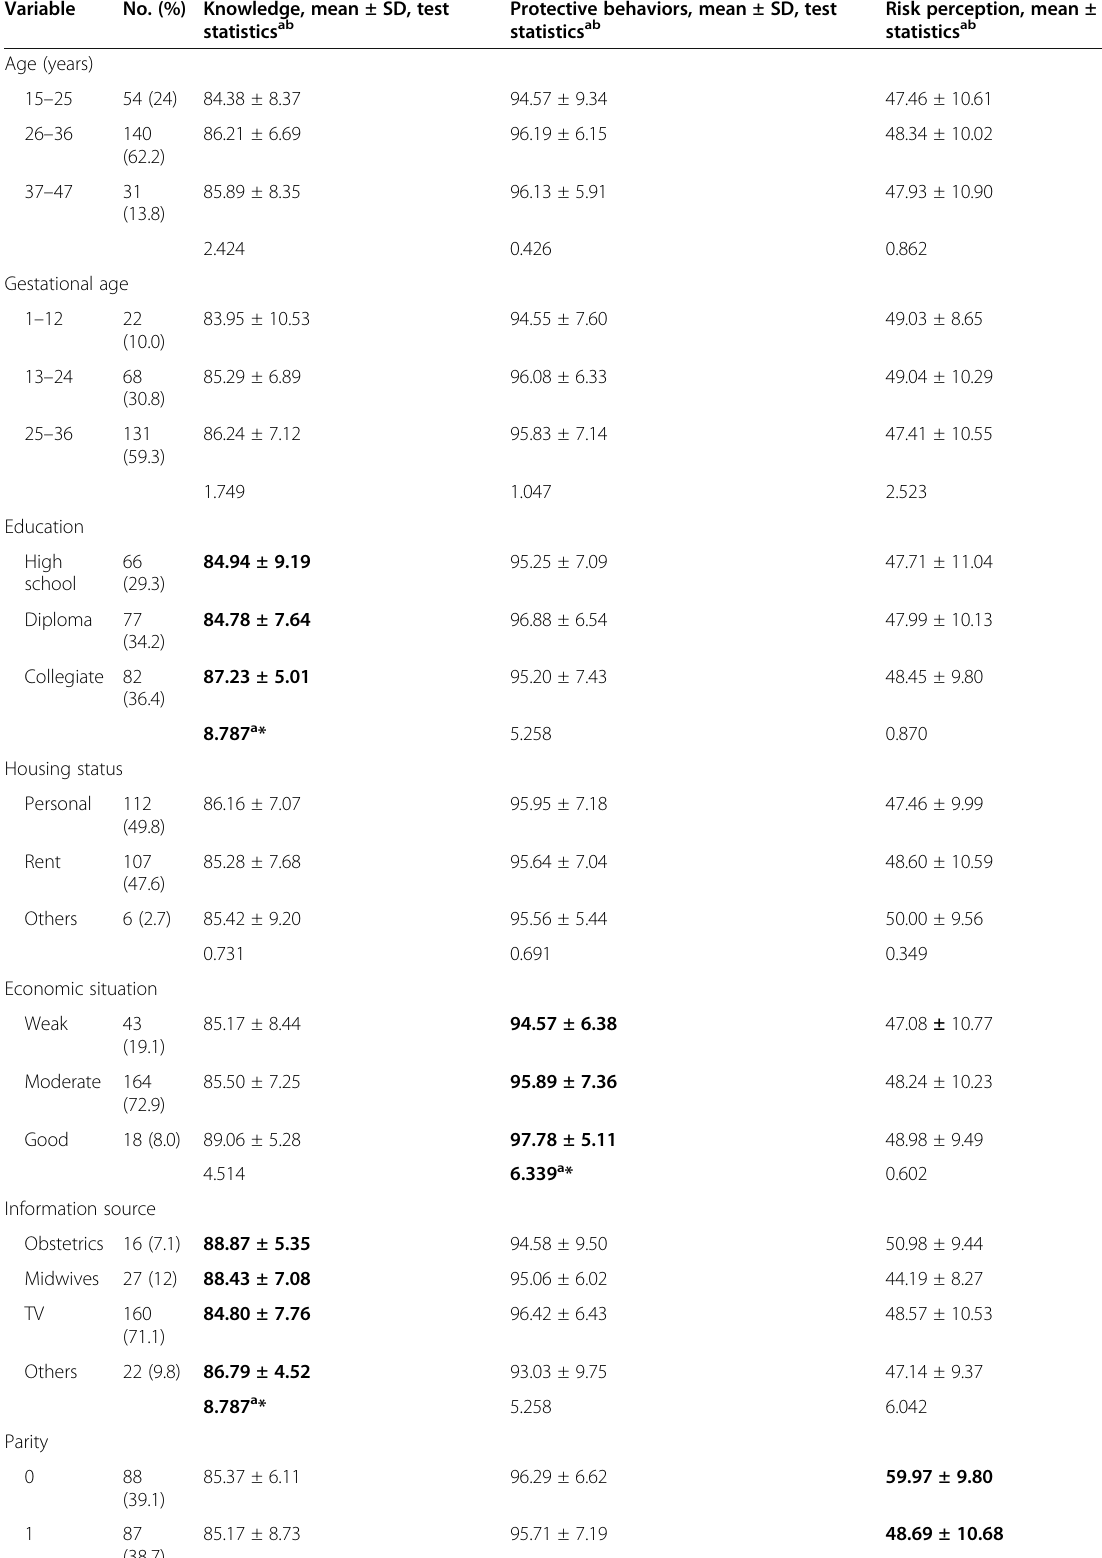
Table 3 Differences in major variables according to demographic and obstetrics characteristics